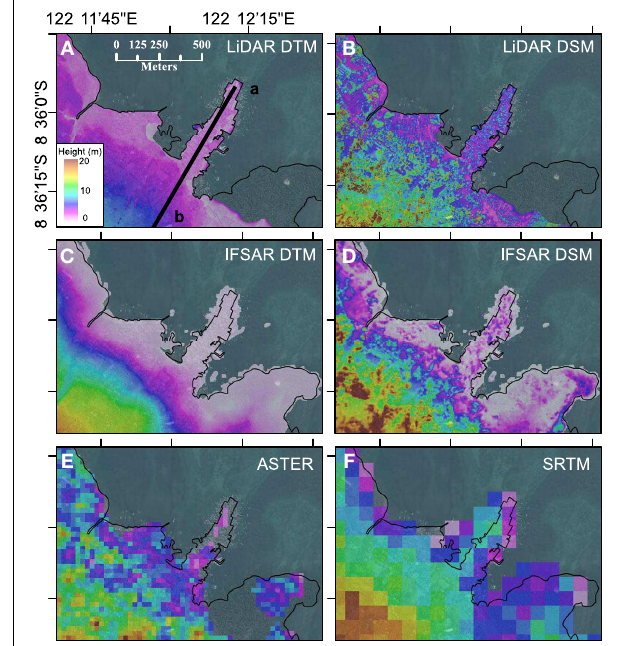
FIGURE 1 | Comparison of elevation data for the Wuring Peninsula, Maumere for (A) LiDAR DTM; (B) LiDAR DSM; (C) IFSAR DTM; (D) IFSAR DSM; (E) ASTER30; and (F) SRTM90. Black line is the coastline digitized from high resolution imagery collected during the LiDAR survey. Line a-b in (A) defines the cross-section shown in Figure 2 . See Figure 5 for location of Wuring Peninsula. Underlying imagery from Bing Imagery accessed through